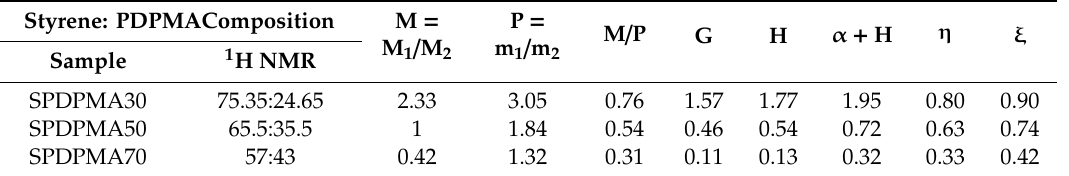
Figure 2. NMR spectrum of styrene-PDPMA copolymer (in the feed ratio 70:30) in CDCl 3 . Table 2. Finemann-Ross (FR), and Kelen-Tudos (KT) parameters for the copolymerization of styrene and PDP methacrylate.